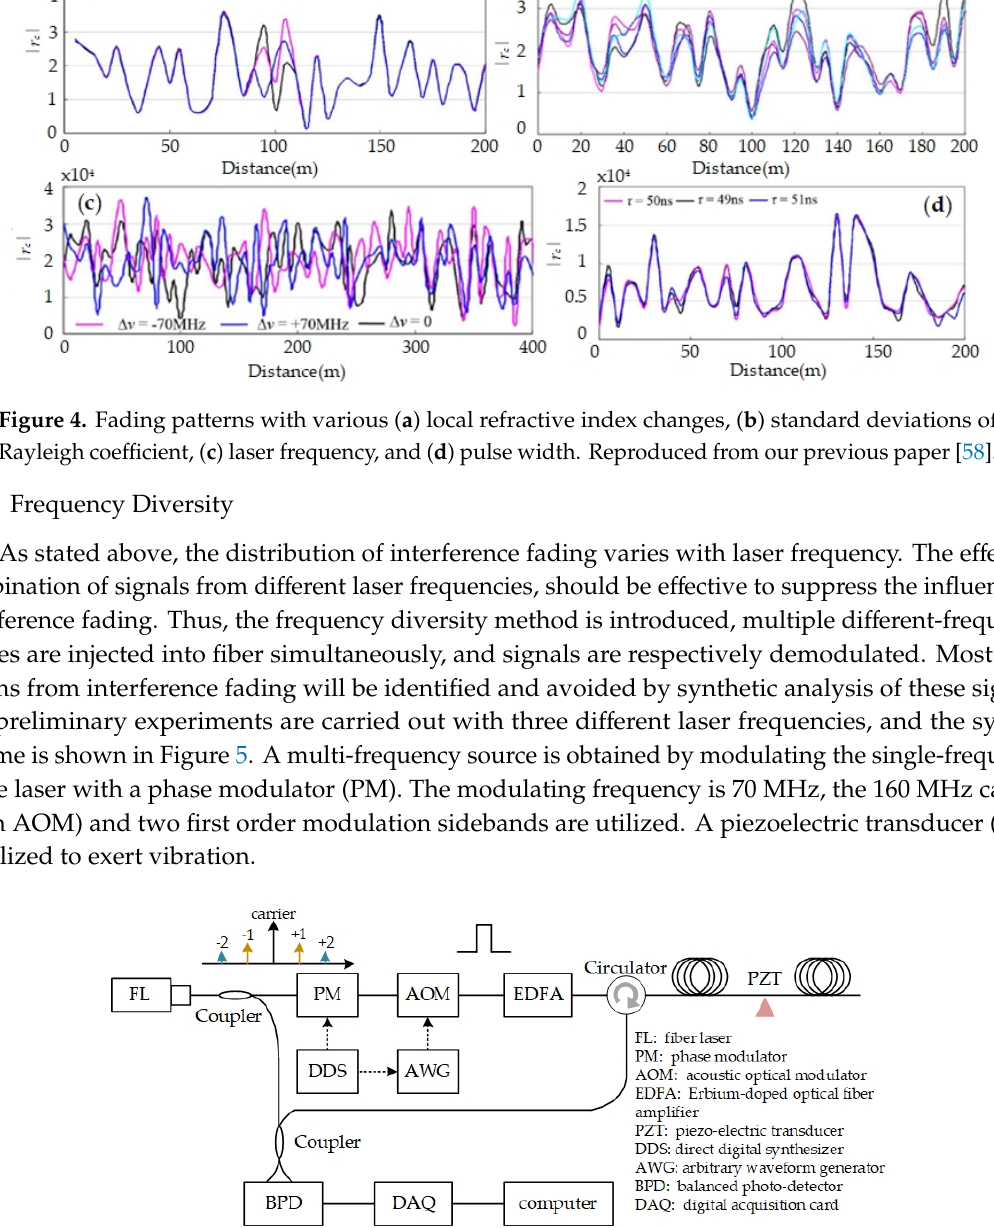
Figure 6. Experimental results. ( a ) Frequency spectrum of beating signals; Demodulation results with different laser frequencies: ( b ) 90 MHz, ( c ) 160 MHz and ( d ) 230 MHz. Reproduced from our previous paper [62].